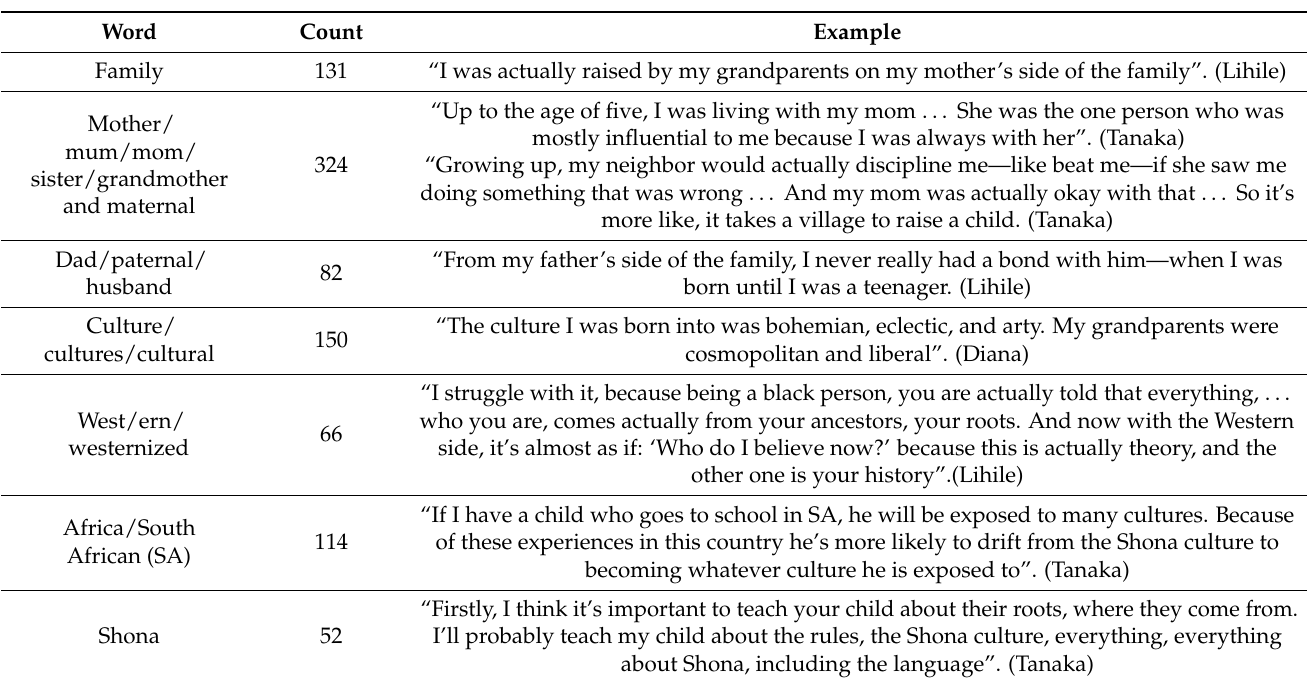
Table 2. Examples of word count with references (NVivo